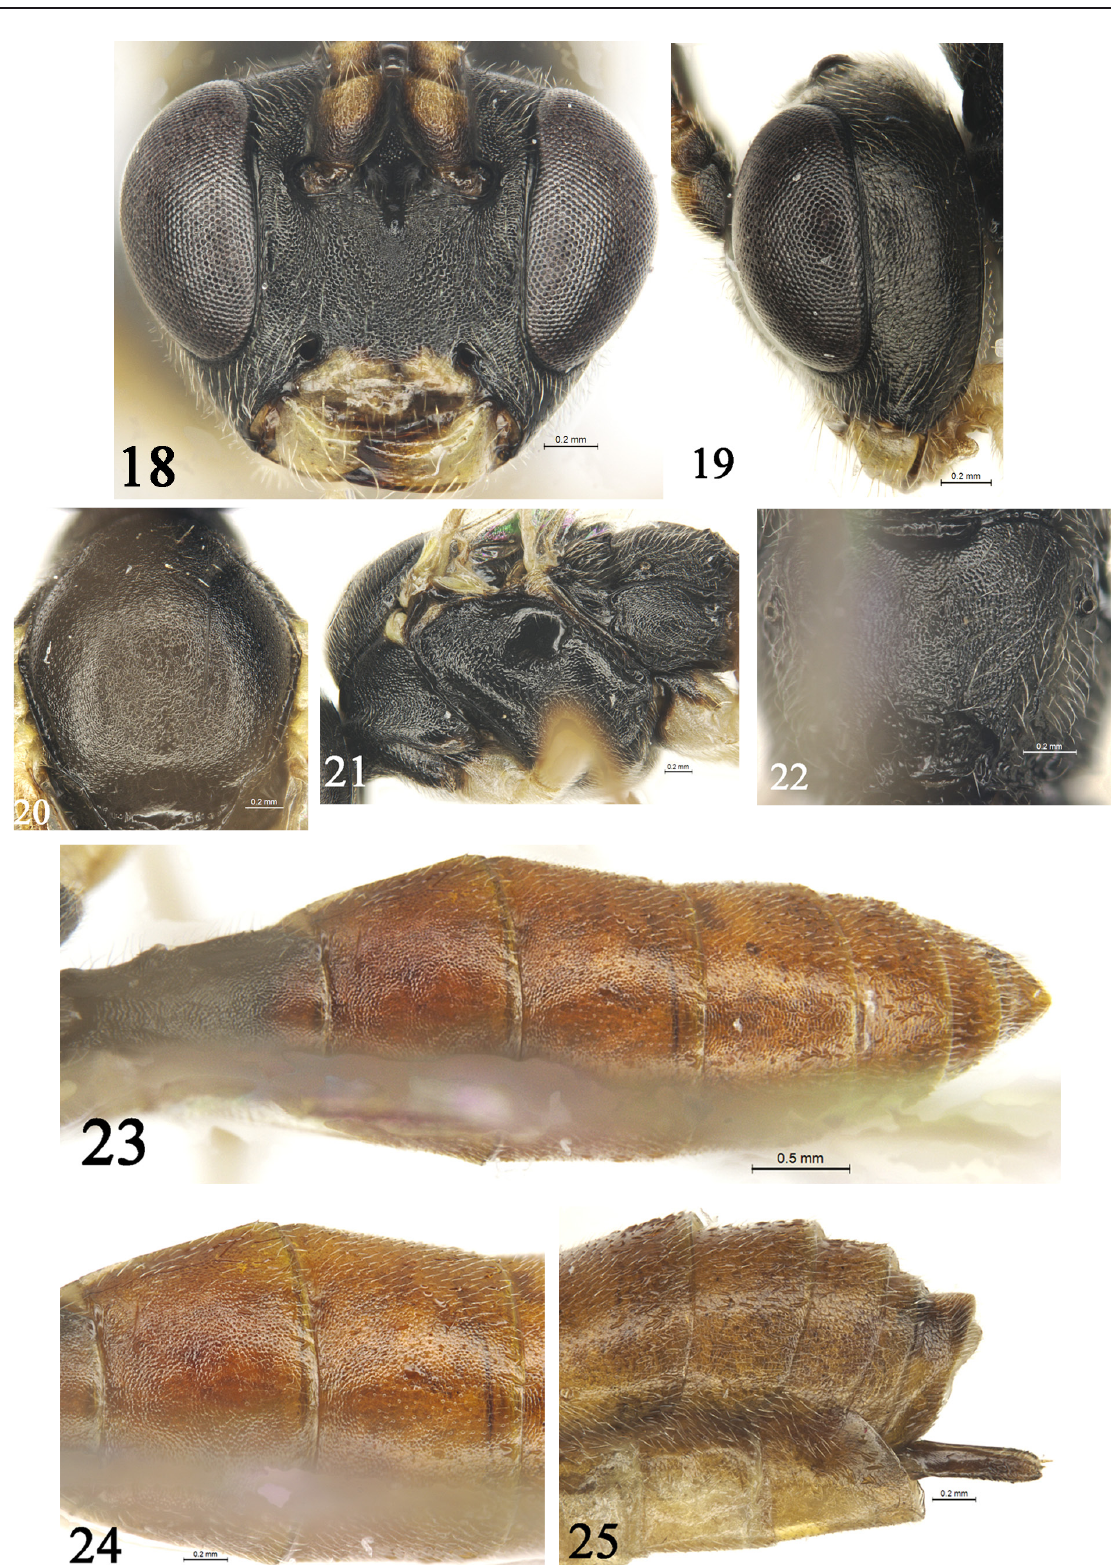
Figs 18–25. Campodorus shandongicus Sheng, Sun & Li sp. nov., holotype, ♀ ( GSFGPM). 18 . Head, anterior view. 19 . Head, lateral view. 20 . Mesoscutum. 21 . Mesosoma, lateral view. 22 . Propodeum. 23 . Metasoma, dorsal view. 24 . Tergites 2–3, dorsal view. 25 . Apical portion of metasoma, lateral